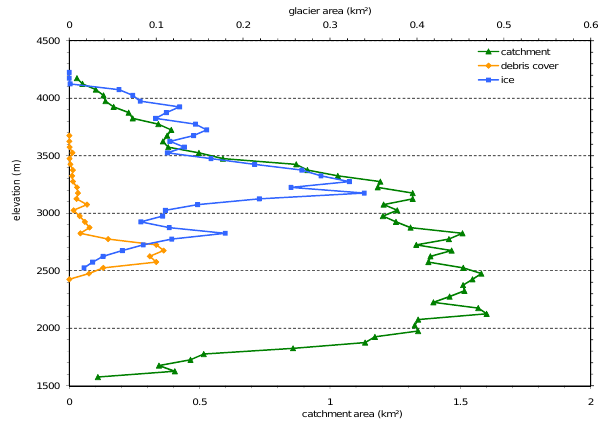
Fig. 7. Area elevation distribution for the Zopkhito and Laboda Glaciers based on the manually delineated glacier boundaries for 2006 and the STRM 90 m digital elevation model. Note the differ- ent scales for the area of the glaciers and the catchment (upper and lower x-axis).